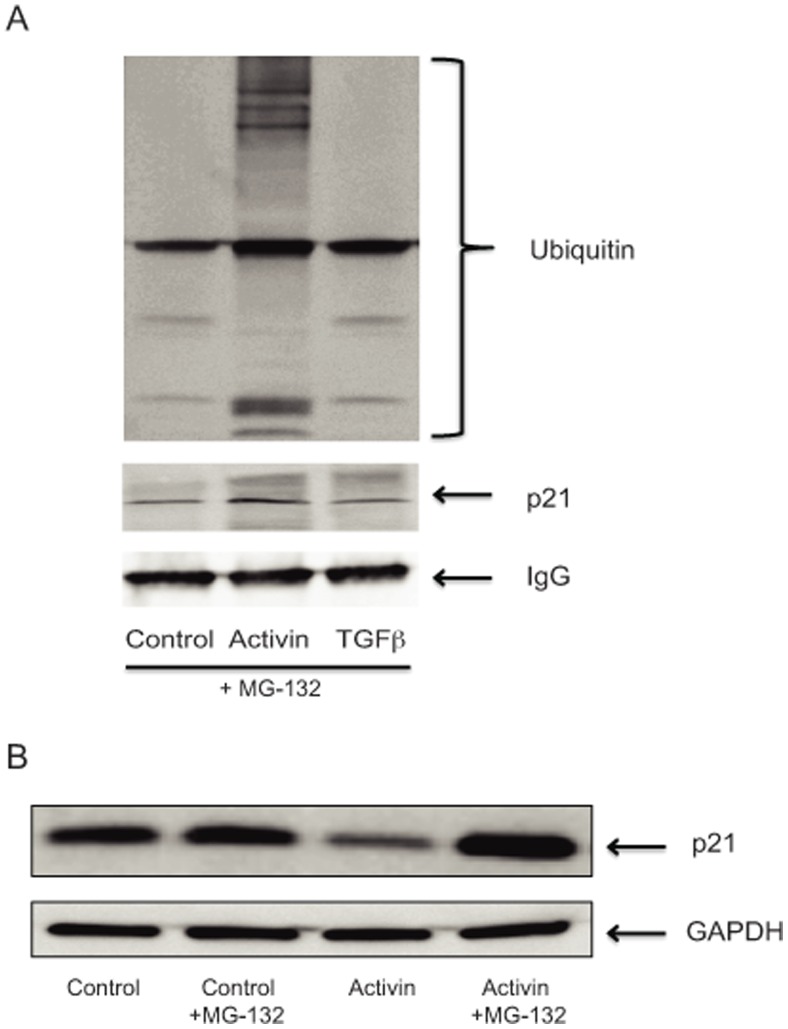
Activin-induced p21 downregulation is associated with ubiquitination and counteracted by proteasomal degradation.A) ACVR2/TGFBR2/SMAD4-wild type FET cells were were pretreated for 30 minutes with proteasomal inhibitor MG-132 and then treated with vehicle (control), activin, TGFβ for 24 hours and ubiquitination of total p21 was assessed via immunoprecipitation of p21 and blotting with a ubiquitin-specific antibody (upper panel) and reblotting of p21. Multiple bands indicative of polyubiquitination were seen only following activin treatment. B) Activin-induced p21 downregulation is dependent on the proteasome. SMAD4-wild type FET cells were pretreated for 30 minutes with proteasomal inhibitor MG-132 followed by treatment with vehicle (control) or activin for 24 hours and compared to cells treated accordingly without proteasomal inhibition. p21 expression was assessed and showed inhibition of p21 downregulation following activin treatment in conjunction with proteasomal inhibition.